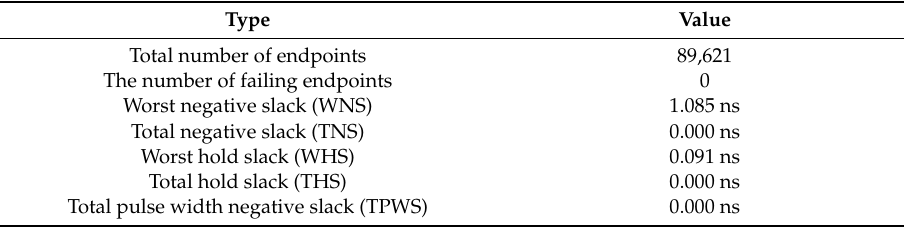
Table 4. The timing results of the postimplementation of the FRMCO with 500 samples in 20 groups.